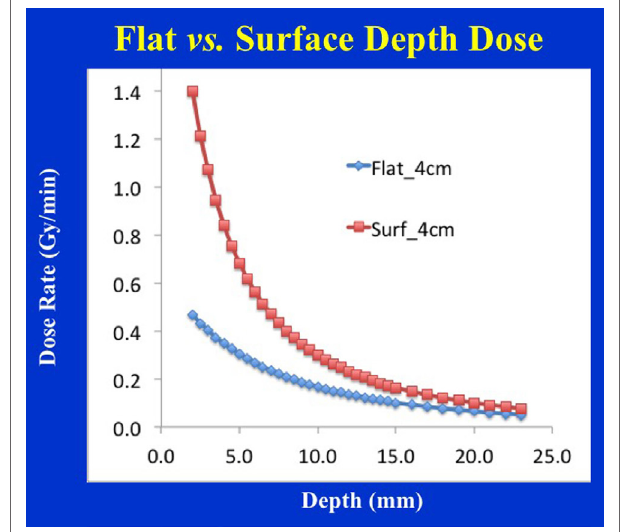
FigUre 14 | Depth-dose profile comparison for 4 cm diameter flat vs. surface applicators. Notice the steep dose-fall of with depth for the surface applicator resulting in inferior dose homogeneity, larger output factor, and shorter treatment